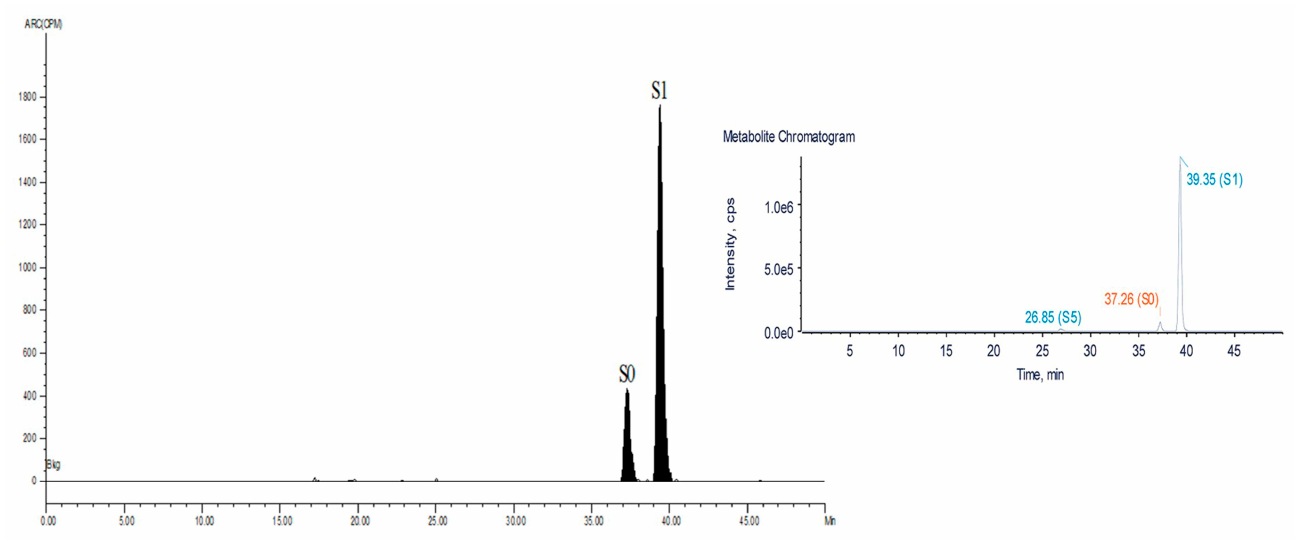
Figure 3. Radiochromatogram and total extracted ion chromatogram (EIC) of SMZ and its metabo-